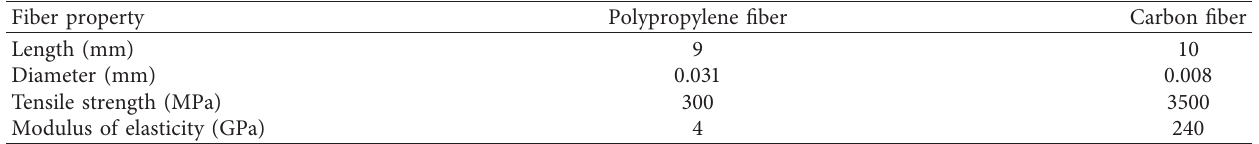
Figure 1: Fiber materials used in the fiber-reinforced concrete. (a) Polypropylene fibers. (b) Carbon fibers. Table 1: Properties of fiber materials used in the concrete specimens.